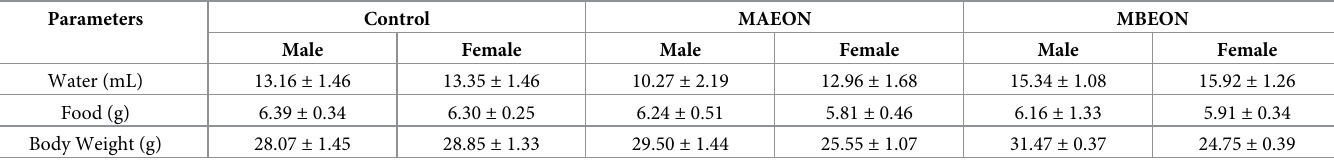
Values are expressed as mean ± standard deviation (n = 3). Statistical significance was calculated using One-way Anova followed by Bonferroni’s multiple comparison test (p < 0.01).